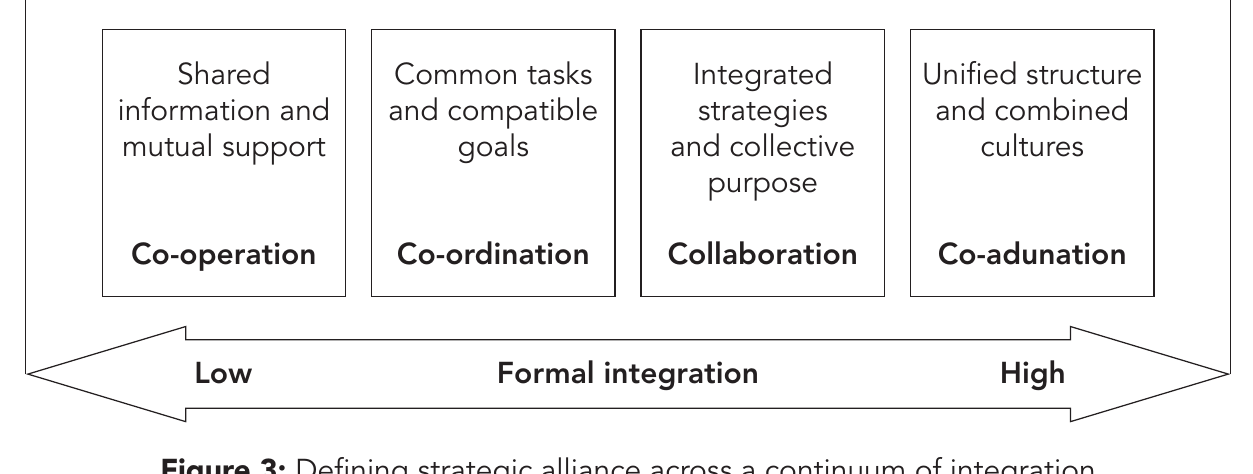
Figure 3: Defining strategic alliance across a continuum of integration Source: Gajda,